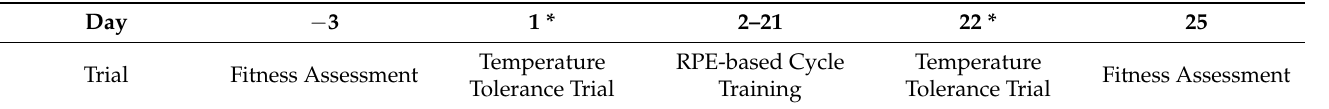
Table 1. Experimental